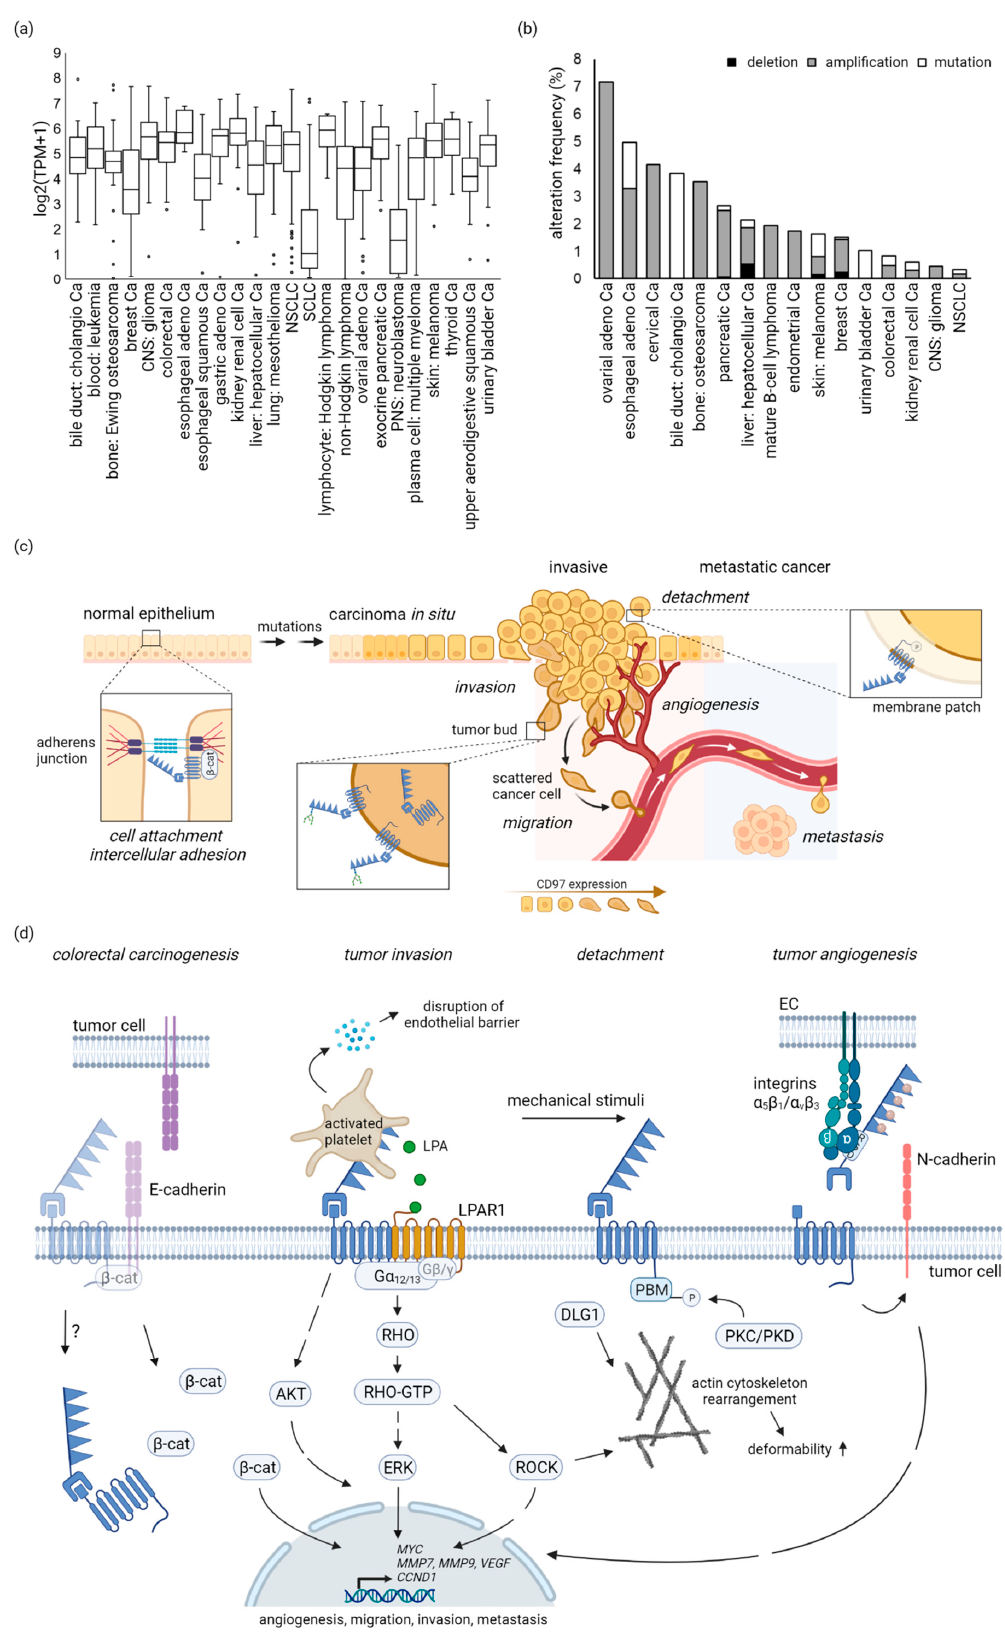
Figure 2. CD97/ ADGRE5 in human cancer. ( a ) ADGRE5 levels in tumor-derived cell lines , grouped by lineage-derivation, in part with subtypes such as lung cell lines (Cancer Cell Line